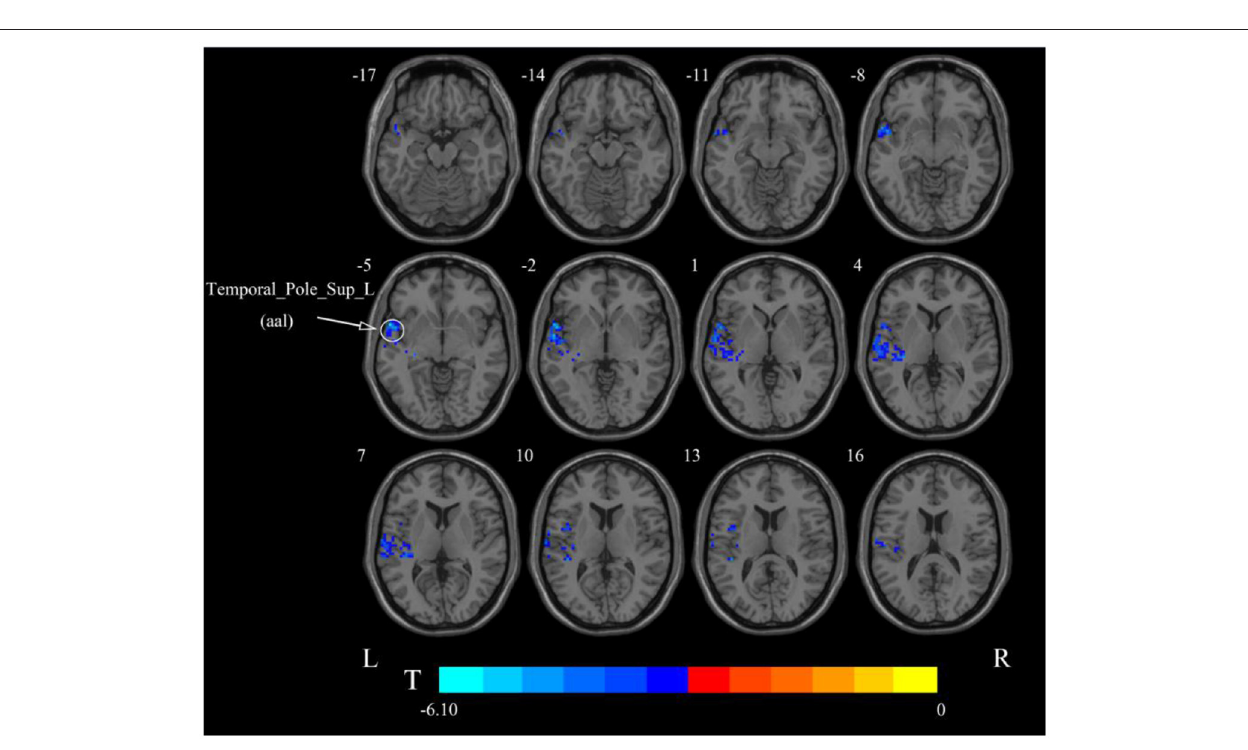
Frontiers in Human Neuroscience |